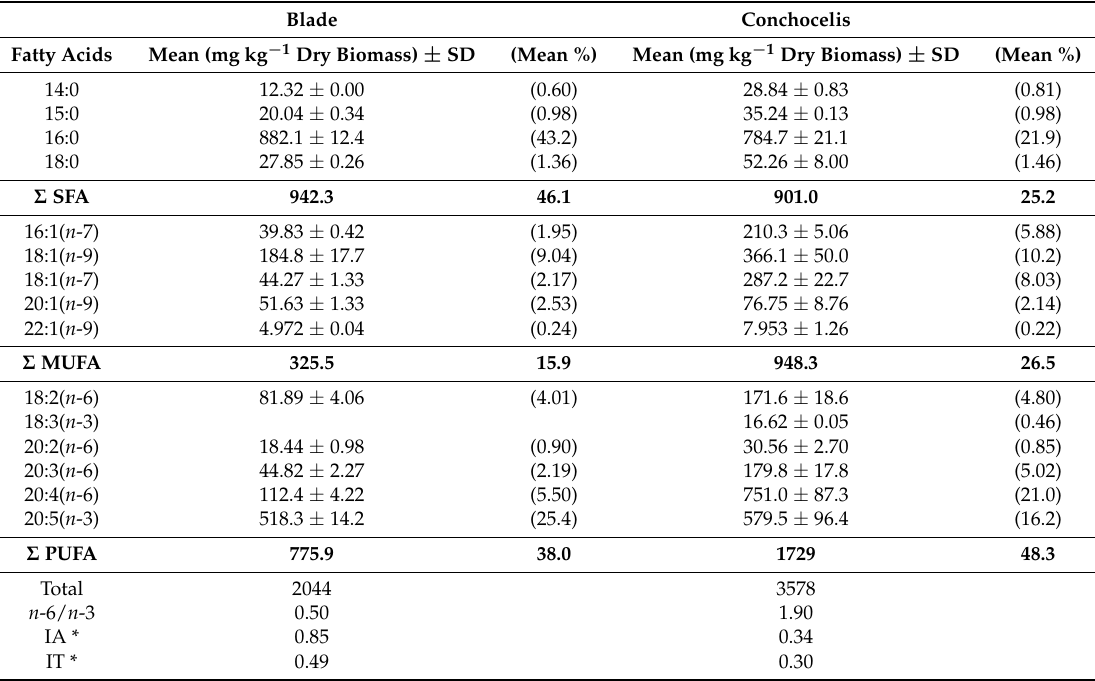
Table 1. Fatty acids profile of lipid extract from blade and conchocelis stages of Porphyra dioica . Blade